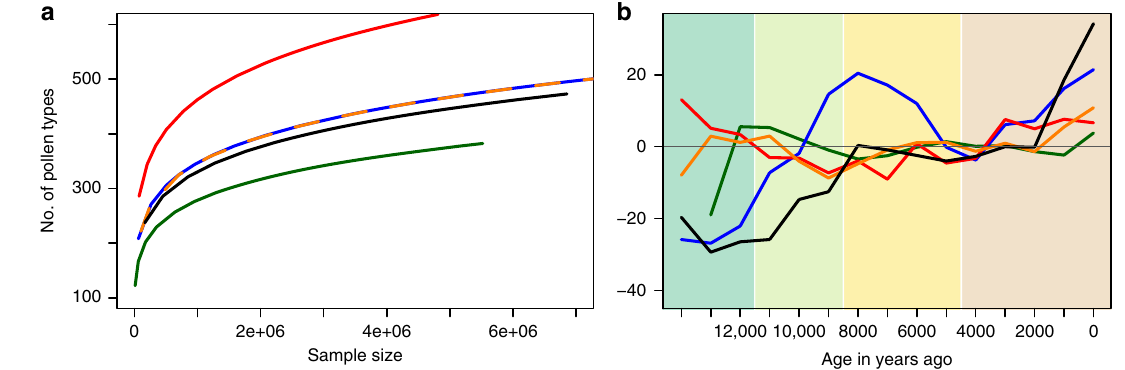
Fig. 4 Taxon accumulation for the regionally summarised samples on all accepted types H 0 . a Power functions describing the overall trend of a common sampling effect (encounter of new taxa with increased sample size) for regions with different richness. b Residuals of the regional taxon accumulation curves (actual values minus the trend in A) plotted against time. The oldest samples show lower than expected numbers of taxa due to a low number of sites and were omitted for clarity. Colour coding as in